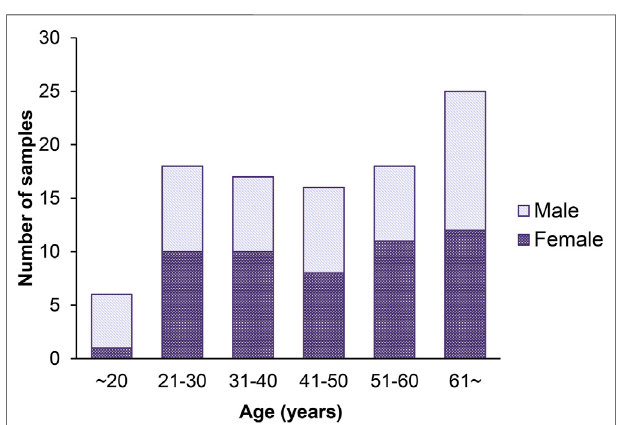
FIGURE2 | Histogram ofthe age distribution for 100 healthy volunteers. The x -axis represents the chronological age of the individuals (age unit is years), and the y -axis (counts) represents the number of individuals.